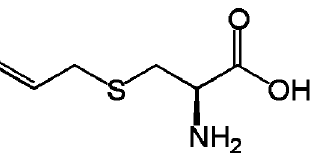
Figure 1. Chemical structure of S-allylcystein.